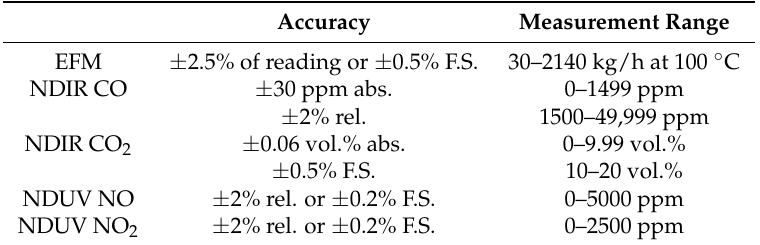
Table 5. The accuracy of the gas analysers and the EFM is small compared to the experimental variability and does not exceed 2.5% of the analysers’ measurement range. The linearity, repeatability and span and zero drift of the gas analysers is neglected in this uncertainty quantification